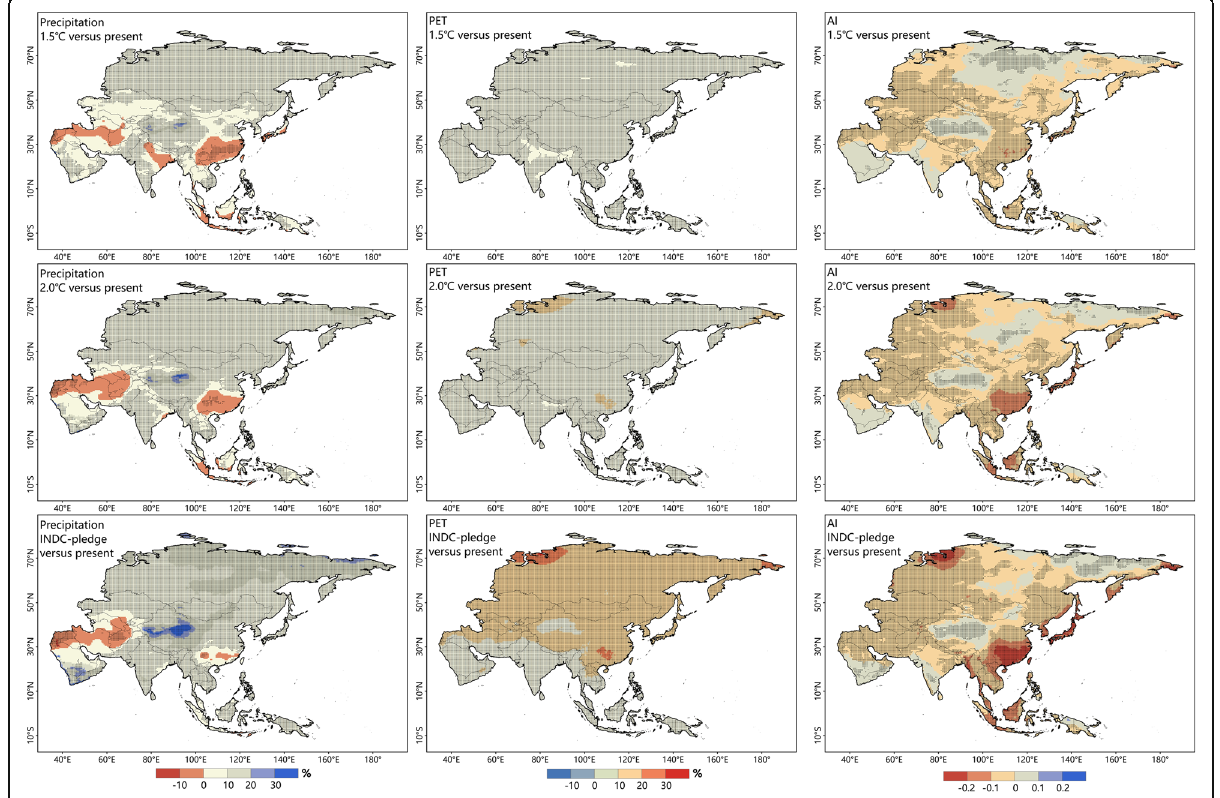
Fig. 3 Changes in annual precipitation, PET, and AI across Asia. Changes in annual precipitation (left column), PET (middle column), and AI (right column) across Asia (multi-model mean). The scenario used is indicated in the upper-left corner of each panel. Black stippling indicates areas where at least 2/3 models agree on the sign of the changes for each